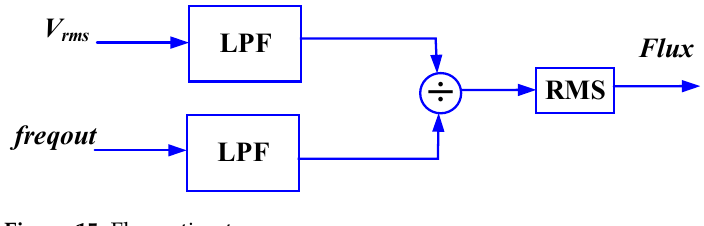
Figure 15. Flux estimator.